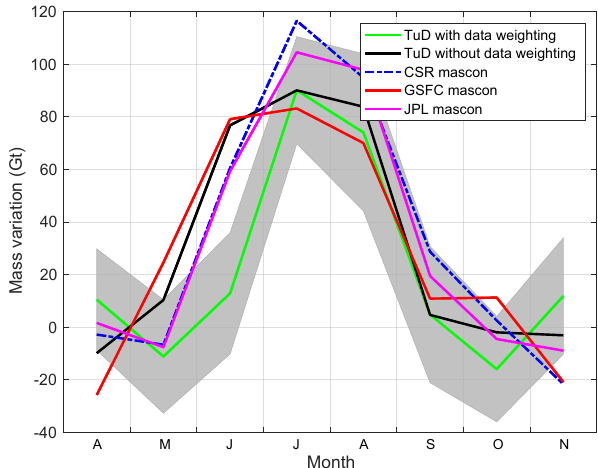
Figure 6. Estimates of seasonal meltwater storage, obtained as the monthly deviations from the April–May and September–November linear fit of “total–SMB” residuals (brown line in Fig. 3): for the whole GrIS (in gigatonnes). Labels along the horizontal axis repre- sent months between April (“A”) and November (“N”). The shaded strip shows the 1 σ error bar for the estimates by Delft University of Technology (TuD) with data weighting (the mean standard devi- ation is 23Gt).